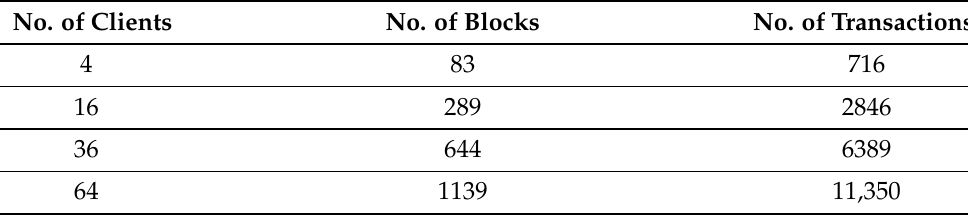
Table 8. Verification of the signature in the swarm network: multi-host-Raft